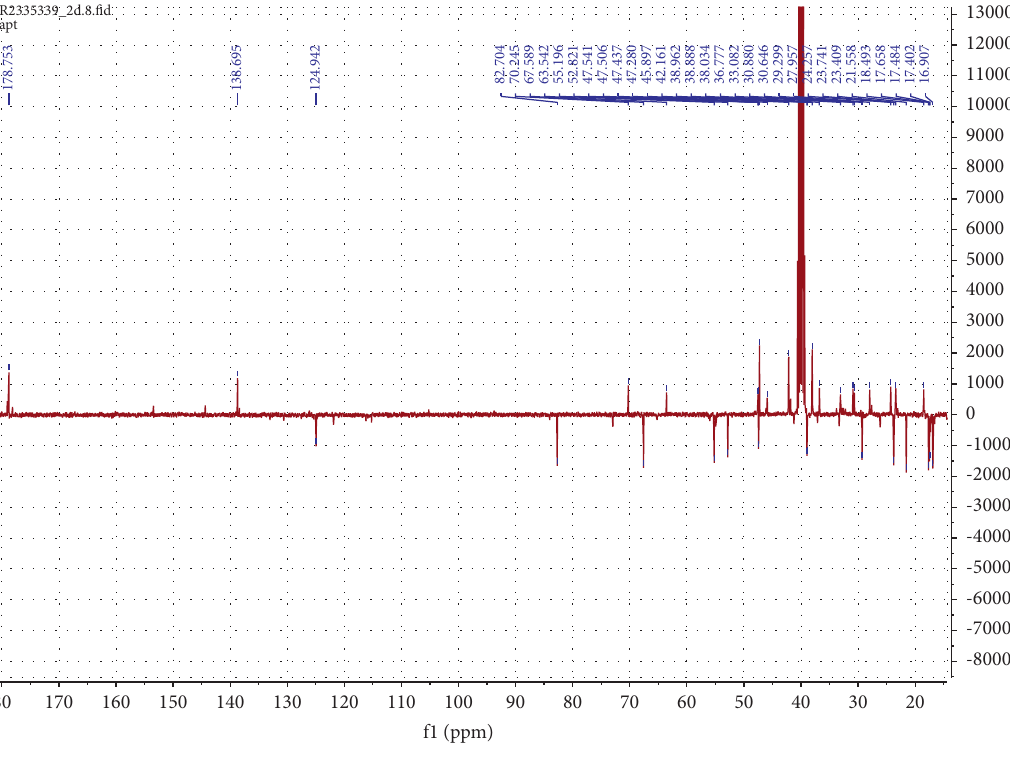
Figure 4: 13 C APT-NMR (DMSO, 100MHz) spectrum of tormentic acid.